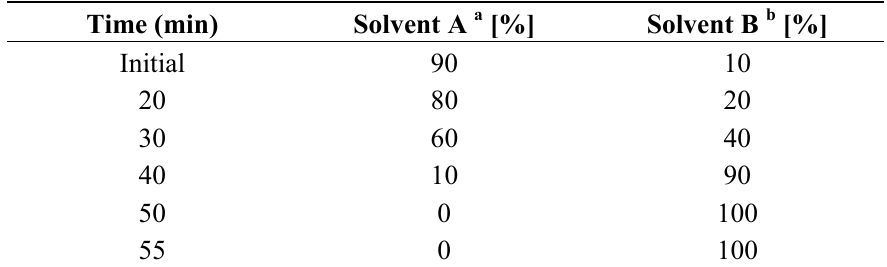
Table 1. Solvent gradient for HPLC